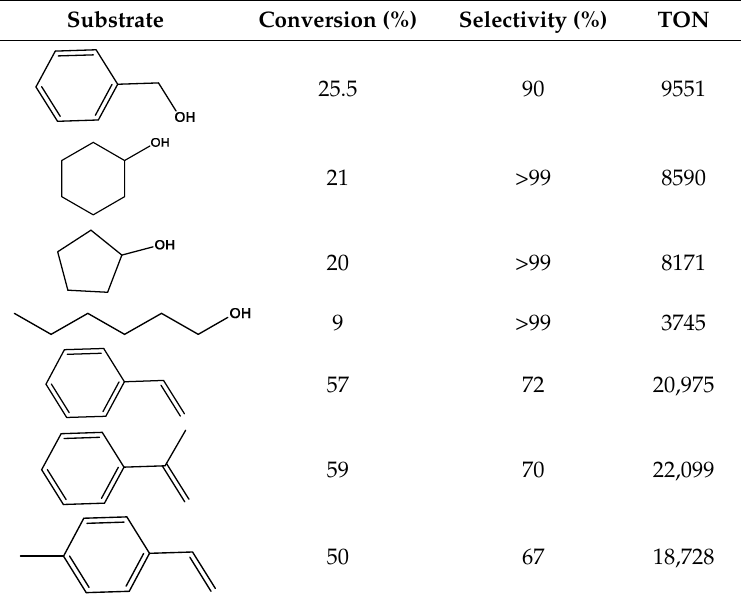
Table 4. Catalytic oxidation of various substrates by oxygen catalyzed with PMo 11 /H β [78] a .